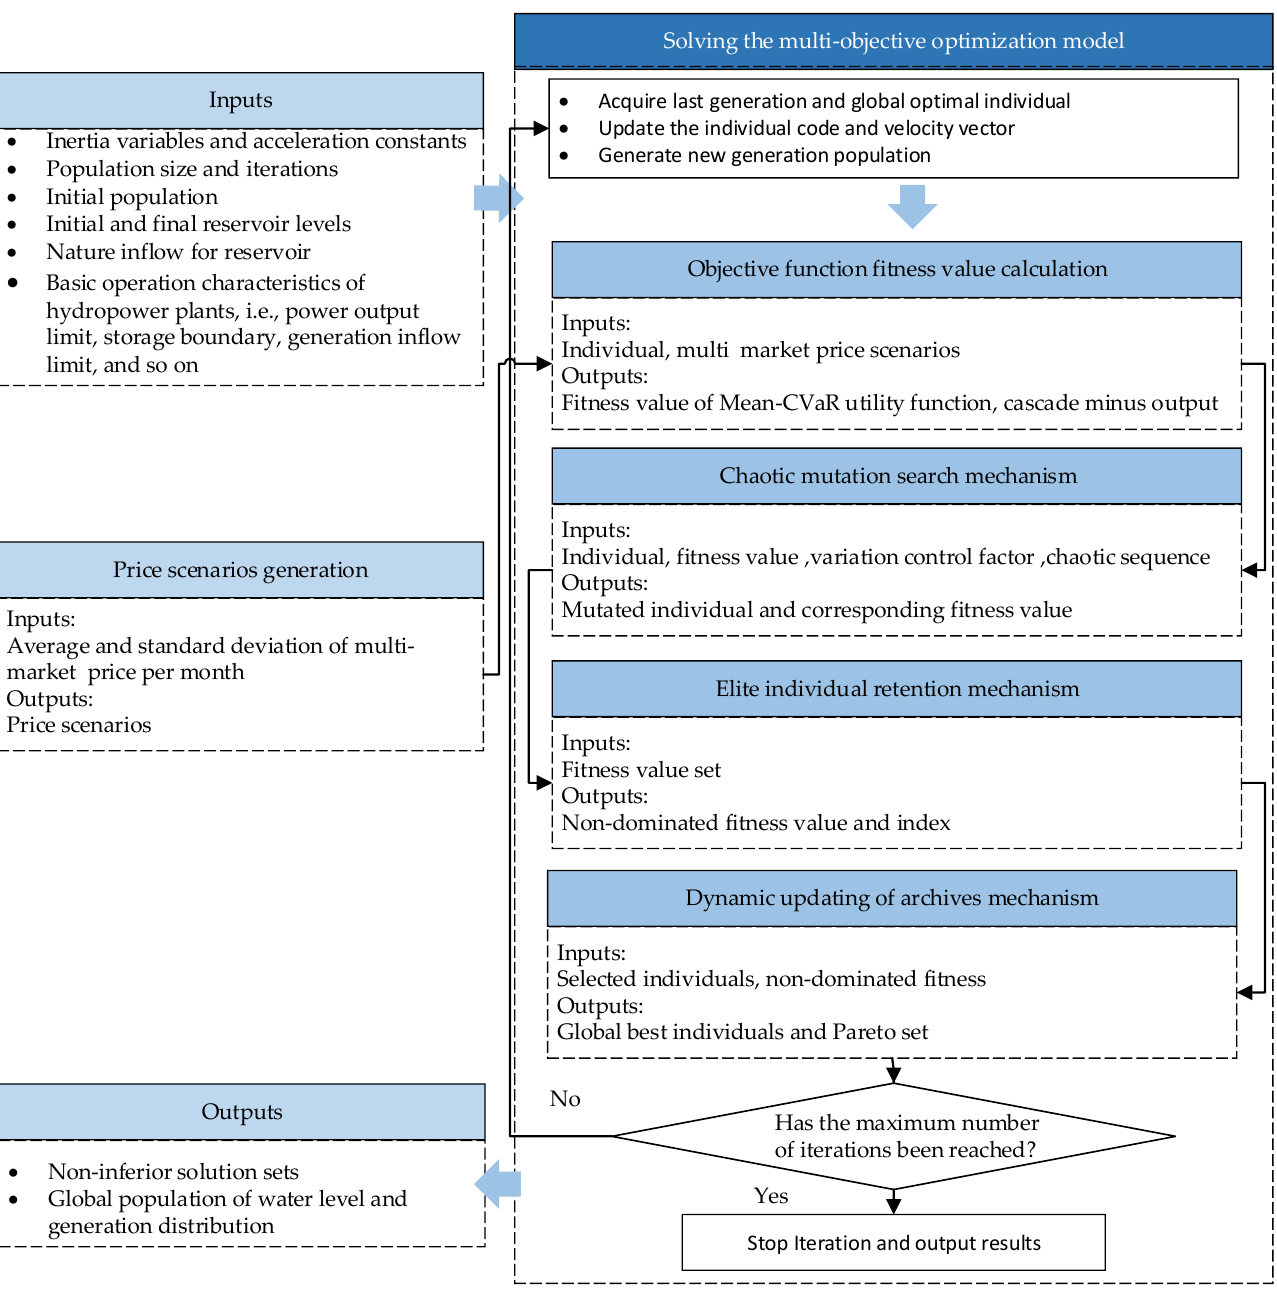
Figure 1. Methodological framework of the proposed optimization model.